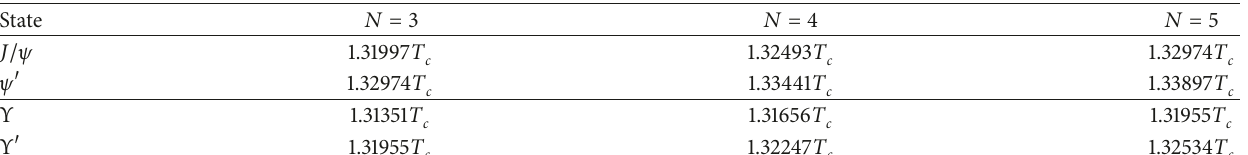
) with T = 203 MeV for the quarkonia states (in units of T D c